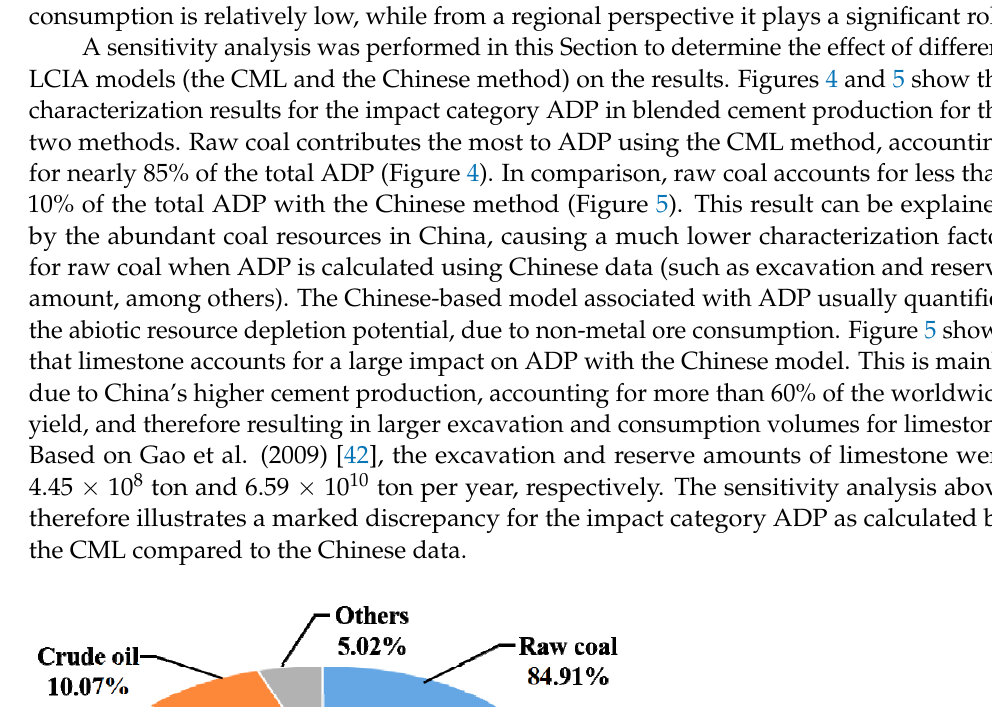
Figure 5. Environmental impacts to ADP of each substance in blended cement with Chinese data. 3.3. Comparison with Other Studies In this Section, comparison analyses were carried out with two similar LCA studies related to cement production in other countries. The system boundaries, production procedures, and applied technology vary widely for the different LCA results of cement production. Some important differences should be discussed and compared with other LCAs studied in corresponding cement production processes. For example, the environmental consequence of OPC production in France was investigated using the CML-IA baseline method by Chen, et al. (2010) [43] (FU: 1 kg of cement). Input data were obtained from a cement manufacturer in France and the output data were identified as the average value collected from 15 cement plants with similar production procedures to our study. The comparison between Chen, et al. (2010) [43] and this study was then performed. Lower impacts were generally found in all categories for our present study. The ADP is considerably lower than that of Chen, et al. (2010) and was predominantly caused by natural resources consumption. Most of this impact category can be attributed to fossil fuel (raw coal) consumption, which is used both to provide heat and to achieve